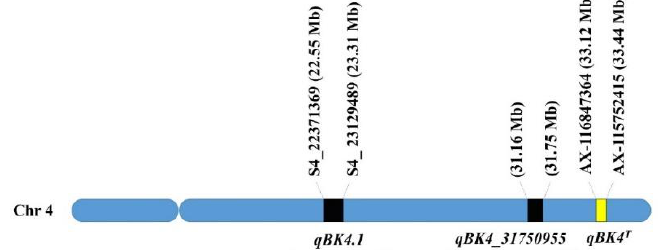
Figure 6. Physical locations of bakanae disease resistance quantitative trait loci on chromosome 4.